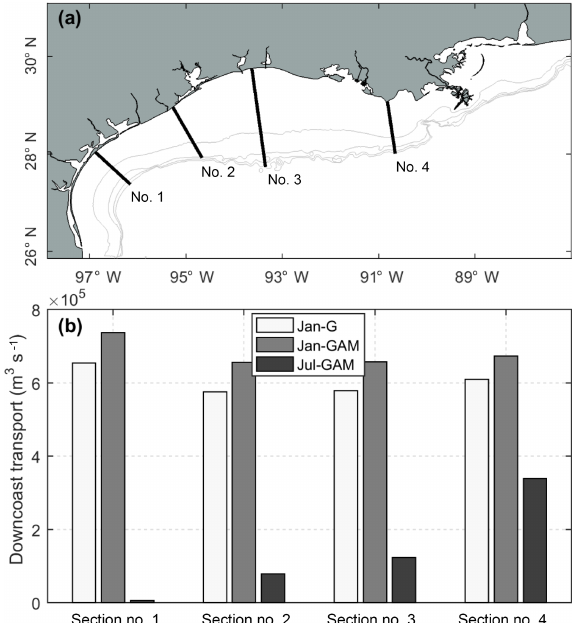
Figure 11. Downcoast longshore transport at four selected cross- shelf sections for three numerical experiments with constant long- term mean river discharges: river discharges into Galveston Bay only with January 2018 wind (Jan-G) and the MAR discharge as well as discharges into Galveston Bay with January 2018 wind (Jan- GAM) or July 2018 wind (Jul-GAM).